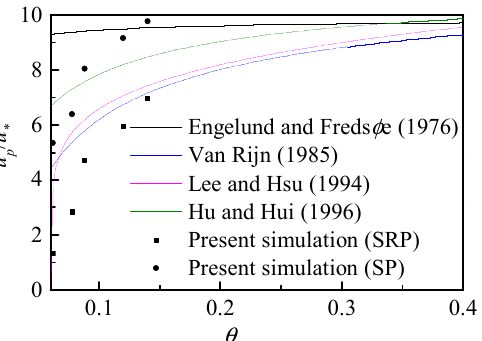
0.1 Figure 18. Comparison of dimensionless streamwise velocity of moving particle between the present model results and the empirical formula with Shields number [7,8,11,13]. It is well known that the sediment particles move in both translational and rotational motion, and the rotation of sediment particles has a significant effect on their trajectories [8,9,25]. Sediment particle rotation occurs under the combined effects of the bed roughness, particle-bed collision, and the velocity gradient of the carrier fluid. In the previous experiment, the particle’s angular velocity was hard to describe exactly due to the limits of the measurement technique. The dimensionless angular velocity of particle Ω is defined as The frequency distributions of the instantaneous dimensionless angular velocity of the SRP and SP around z direction at the different vertical positions is presented in Figure 19. Through curve fitting of the frequency distributions of instantaneous dimensionless angular velocity, it shows that, for the SRP, the frequency distribution of dimensionless angular velocity follows skew-normal distribution, while for the SP, the frequency distribution of dimensionless angular velocity follows a logarithmic normal distribution. The different distribution patterns are mainly related to the motion modes of the sediment particle. Particle rotation is mainly derived from sediment particle-bed collisions. The SRP slide and roll close to the bed and frequently contact with the bed, while the SP are intermittently losing contact with the bed for a short time and are strongly influenced by the fluid velocity near the bed.